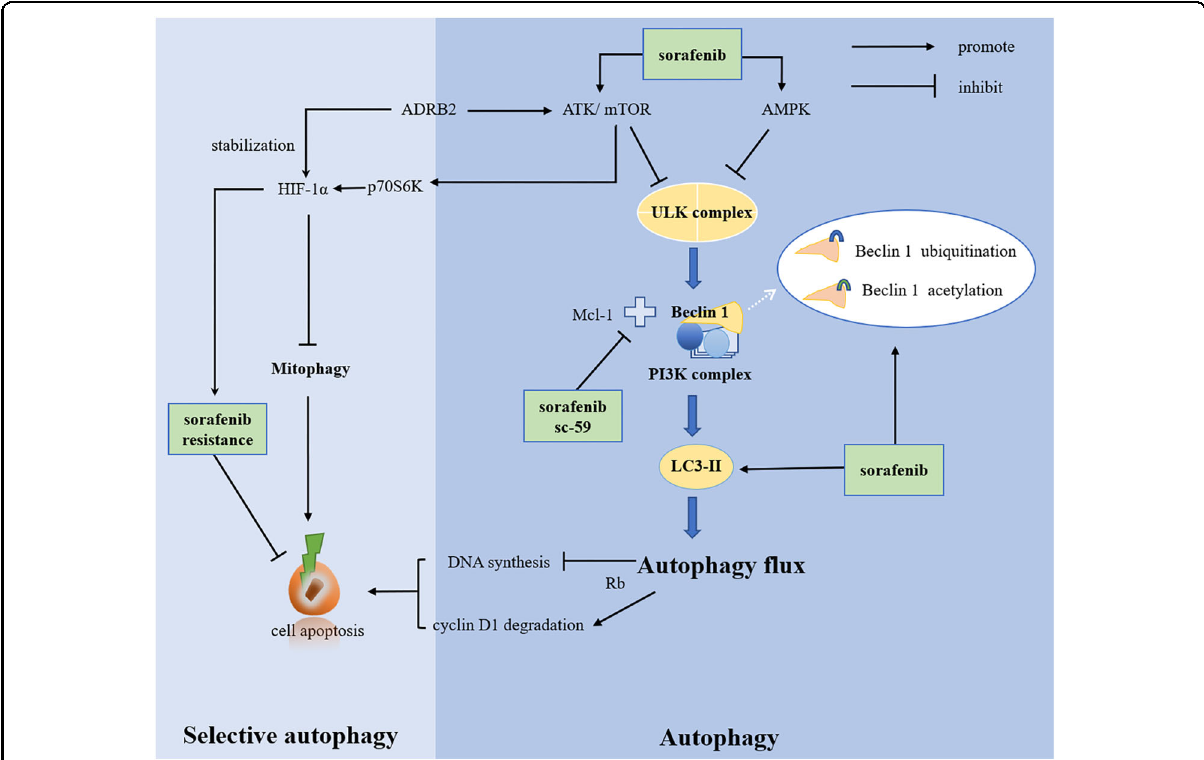
Fig. 2 Sorafenib resistance and autophagy in HCC. The multikinase inhibitor sorafenib activates ATK/mTOR and AMPK signal to inhibit autophagy, causing autophagy-related resistance. Sorafenib in fl uences the autophagy process by affecting the activity of various autophagy proteins. Sorafenib is involved in the chemical modi fi cation (ubiquitination and acetylation) of Beclin 1, which affects the activity of beclin1. In addition, sorafenib and its novel derivative, sc-59, inhibit the binding of Mcl-1 to Beclin 1. Autophagy links to apoptosis with the help of Rb protein, but sorafenib affects the formation of LC3-II, leading to autophagy inhibition and drug resistance that inhibit cell